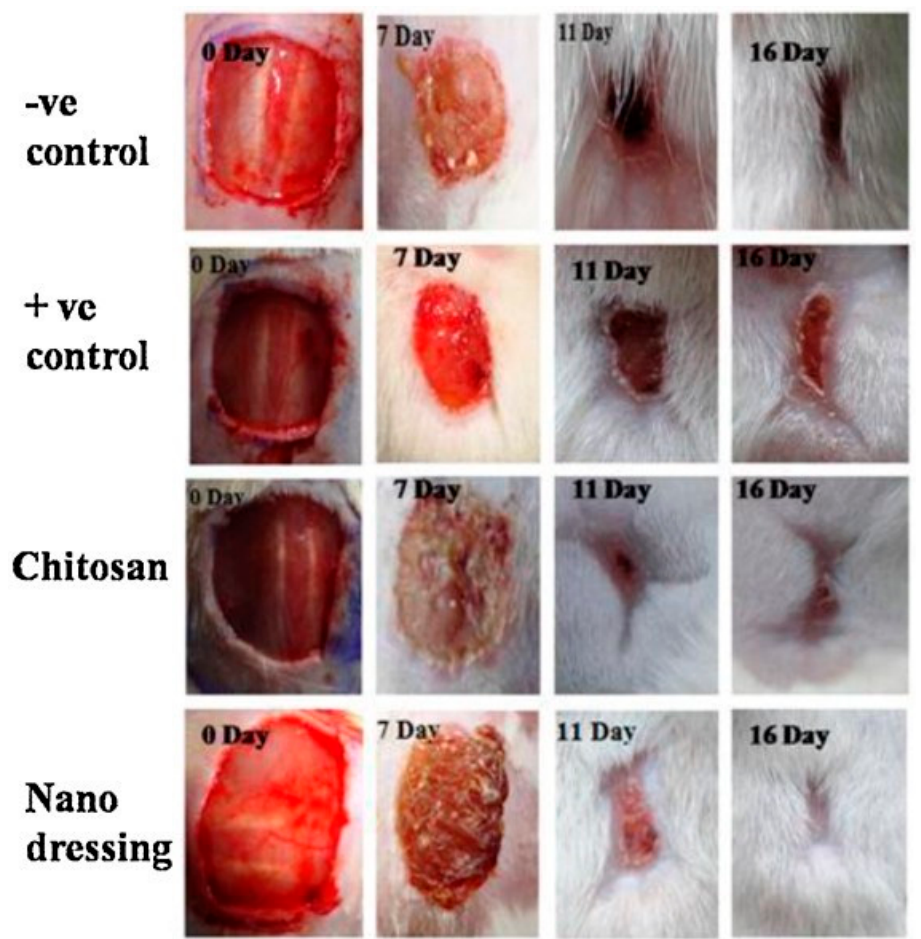
Figure 6. Appearances of wounds treated with controls, chitosan, and chitosan–PVP–TiO 2 dressing. Reprinted with permission from [100], copyright 2013 Elsevier.